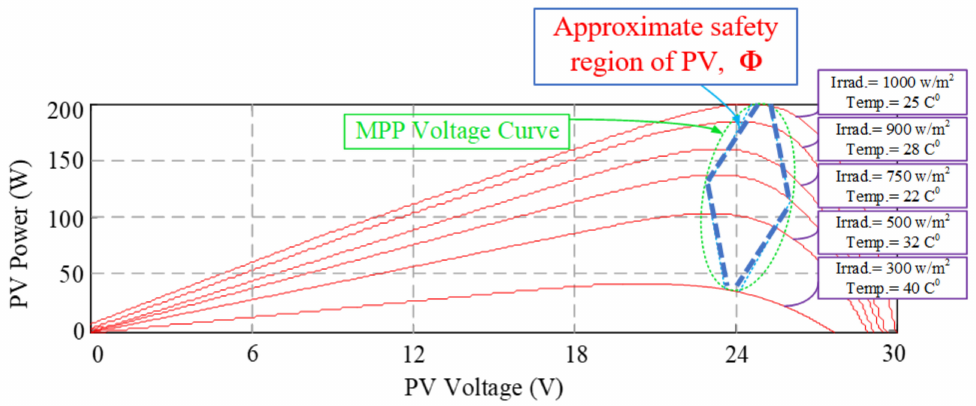
Figure 6. PV curve under different weather conditions for the KYOCERA KC200GT